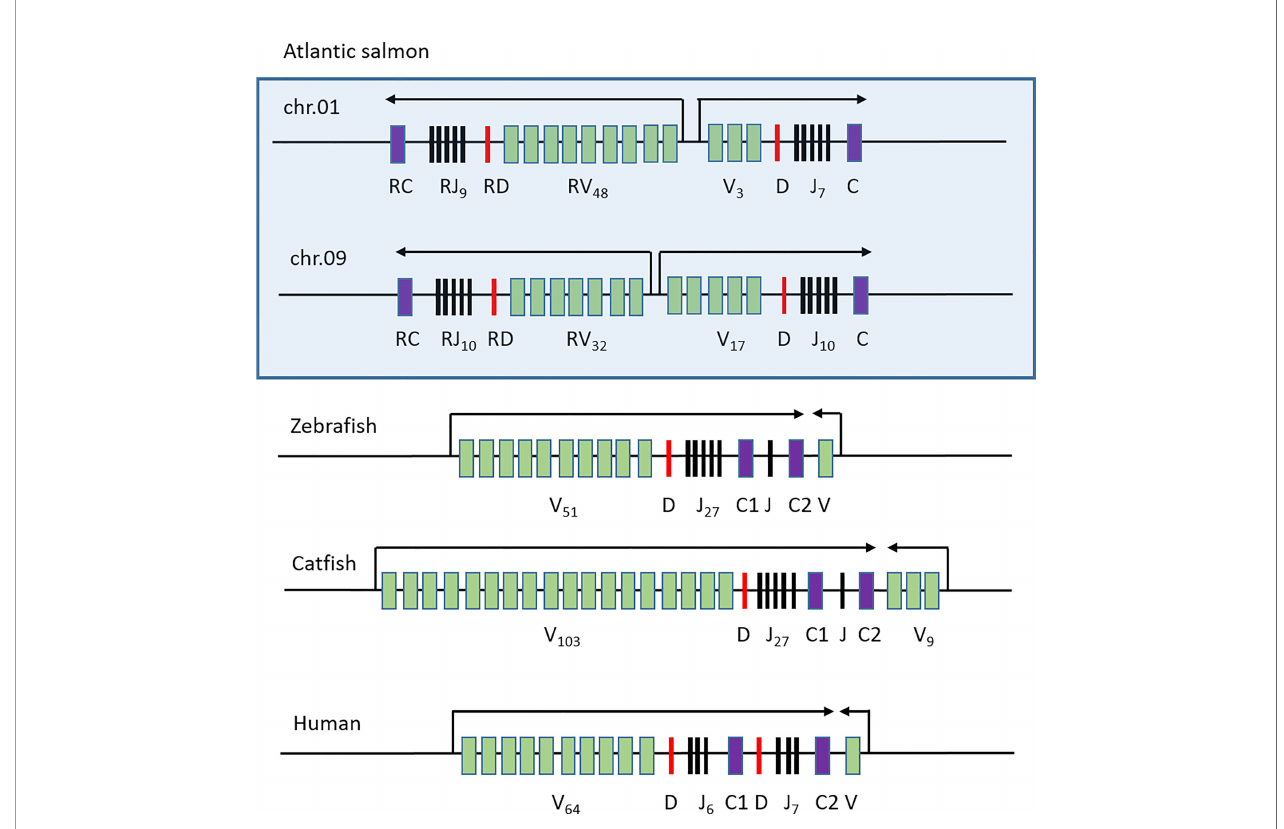
FIGURE 6 | Comparative genomic organization of TRB regions. Genomic organization of the Atlantic salmon TRB01 and TRB09 regions (boxed) compared to those of zebra fi sh (35), cat fi sh (36) and human (52). Constant genes are shown as purple boxes, joining genes as black lines, diversity genes as red lines and variable genes as green boxes. Transcriptional orientation is shown above with arrows and number of individual genes are shown as